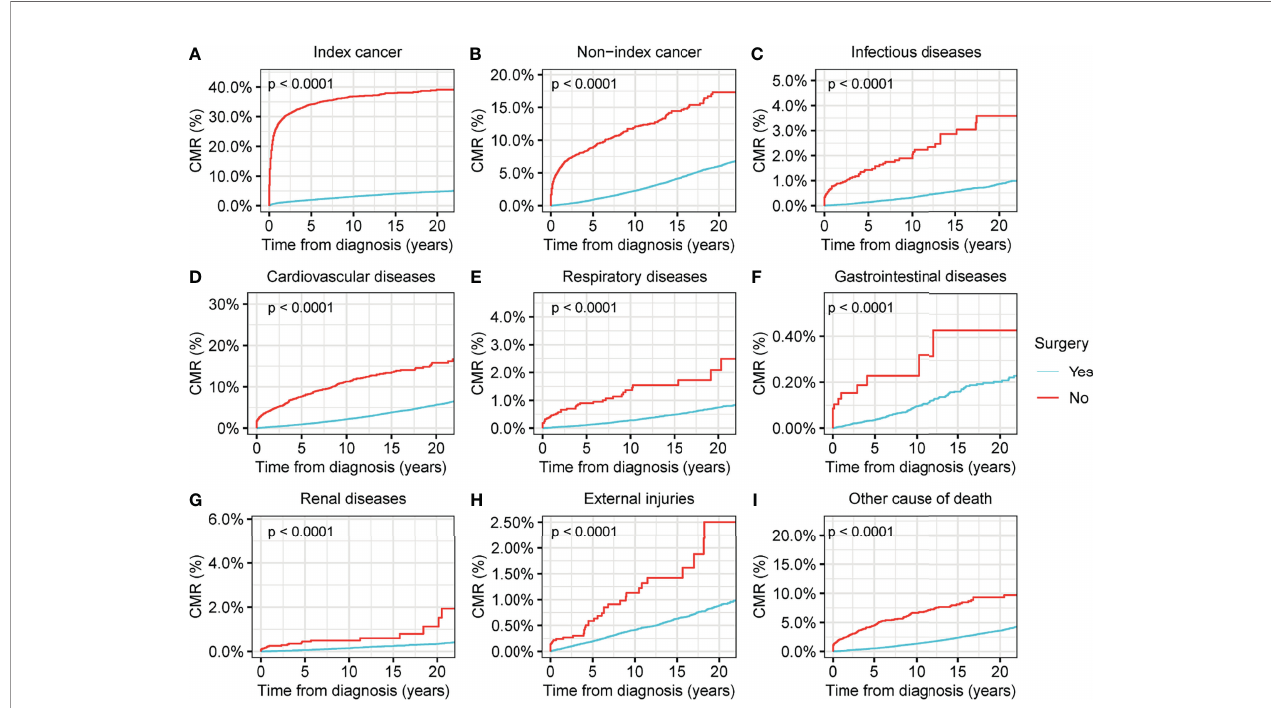
FIGURE 4 | Cumulative mortality rate (CMR) among patients with thyroid cancer by surgery. (A) CMR from index cancer among patients with thyroid cancer by surgery. (B) CMR from non-index cancer among patients with thyroid cancer by surgery. (C) CMR from infectious diseases among patients with thyroid cancer by surgery. (D) CMR from cardiovascular diseases among patients with thyroid cancer by surgery. (E) CMR from respiratory diseases among patients with thyroid cancer by surgery. (F) CMR from gastrointestinal diseases among patients with thyroid cancer by surgery. (G) CMR from renal diseases among patients with thyroid cancer by surgery. (H) CMR from external injuries among patients with thyroid cancer by surgery. (I) CMR from other non-cancer causes among patients with thyroid cancer by